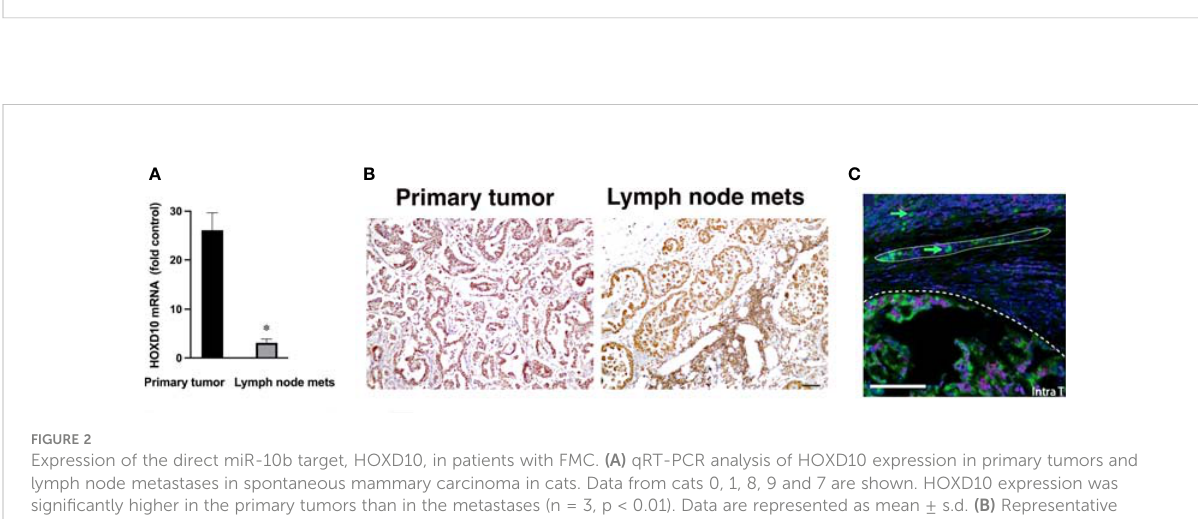
FIGURE 1 miR-10b expression in primary and metastatic tumors from patients with FMC. (A) Representative H&E sections of primary tumors and lymph node metastases from feline patients showing histopathology similar to human breast cancer. Scale bar = 200µm. (B) miR-10b expression in primary tumors and lymph node metastases in feline patients. Molecular subtypes are indicated by the color legend. In 55.5% of the tumors miR-10b expression in lymph node metastases was signi fi cantly higher than in primary tumors with 60% of them being HER2+ (n = 3, p < 0.05).